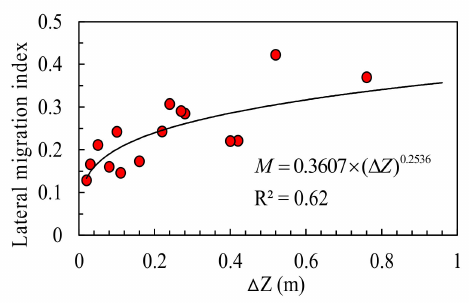
Figure 8. Relationship between the lateral migration index and the variation in TG elevation.